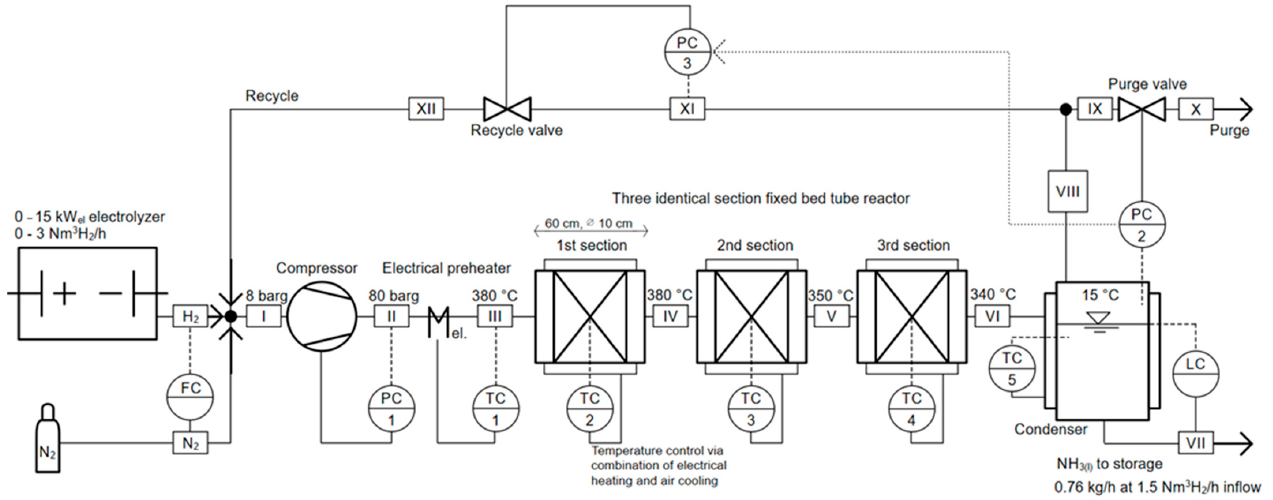
Figure 1 . Process and control diagram of the P2A cycle. Figure 1. Process and control diagram of the P2A cycle. Table 2. Main parameters of the novel P2A design and its implementation in Aspen Plus Dynamics ®